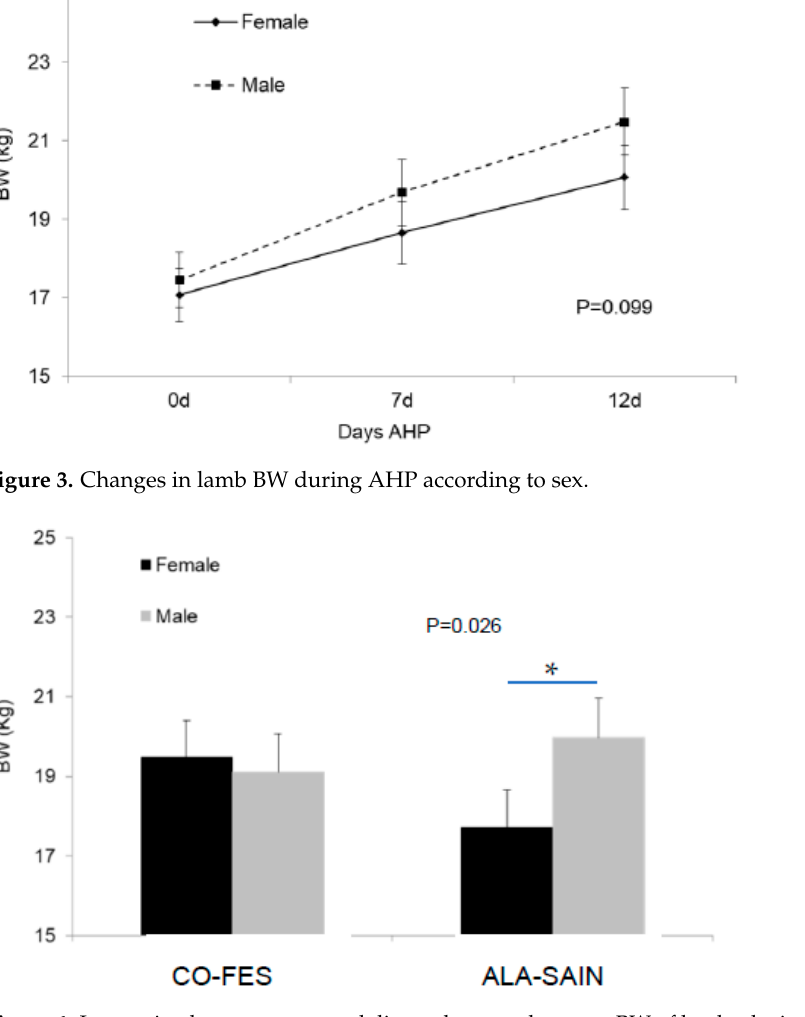
Figure 4. Interaction between pre-natal diet and sex on the mean BW of lambs during AHP. CO-FES—control diet; ALA-SAIN—supplemented diet. Asterisk indicates significant differences between lamb sexes within pre-natal diet.